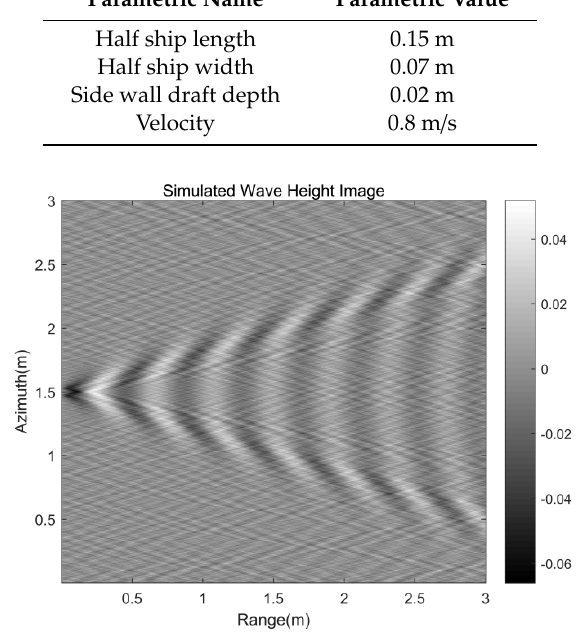
Figure 2. Kelvin wake wave height image.